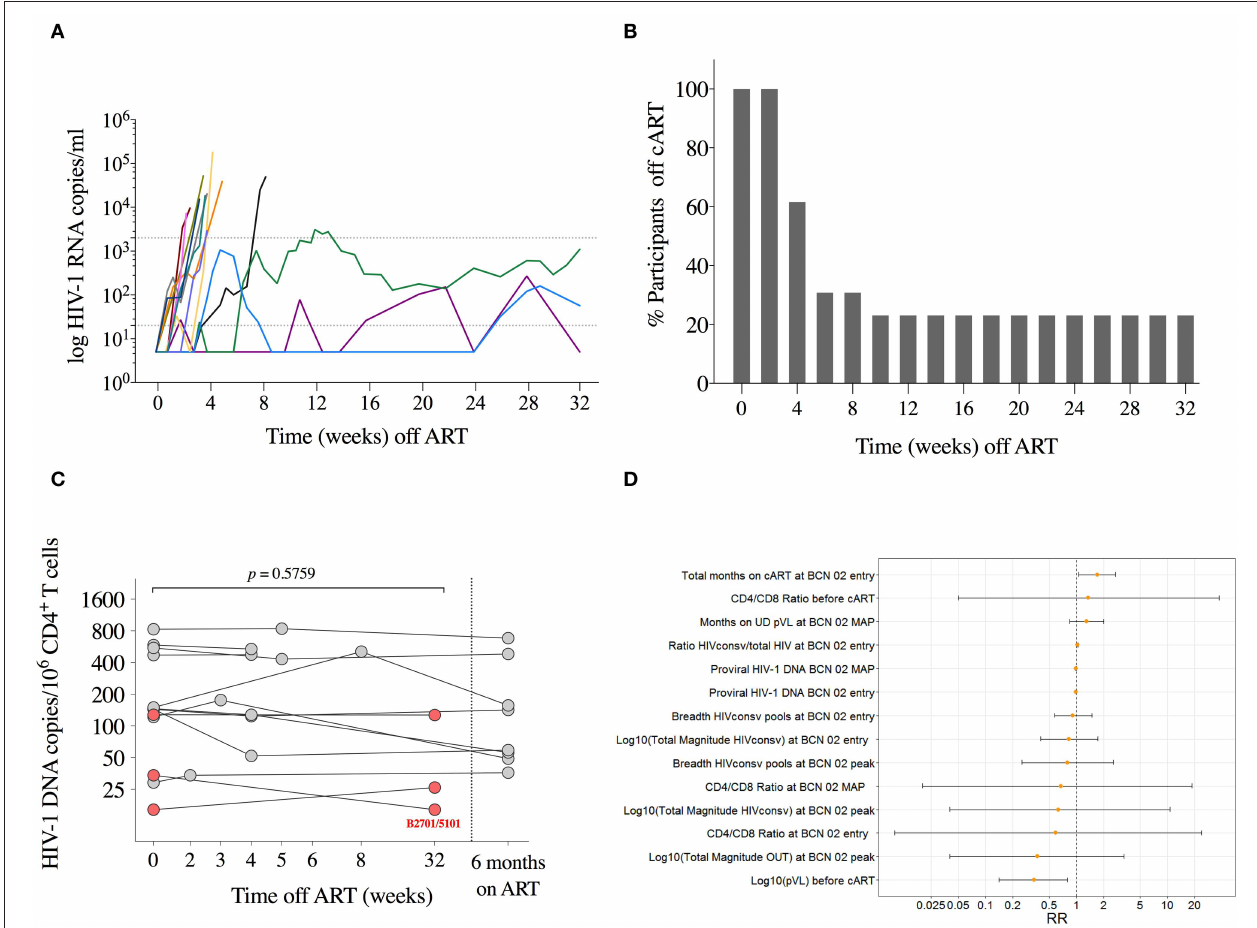
FIGURE 5 | Monitored antiretroviral pause. (A) Individual pVL during MAP is shown for each participant in different colors ( n = 13). Lines are interrupted on day of ART resumption. Dotted lines represent detection limit and threshold for ART resumption (20 and 2,000 copies/ml, respectively). (B) Proportion of individuals remaining off ART during MAP. (C) Total HIV-1 DNA copies/10 6 CD4 + T cells are shown for each participant at MAP initiation, at day of ART ressumption, and 24 weeks after ART. P -value corresponds to comparison between MAP initiation and the day of ART resumption for each individual using the Wilcoxon signed-rank test. Individuals with sustained low-level viremia over 32 weeks are shown in red. (D) Estimated relative risks and 95% confidence intervals for the durable control of pVL during MAP obtained from univariate log-binomial regression